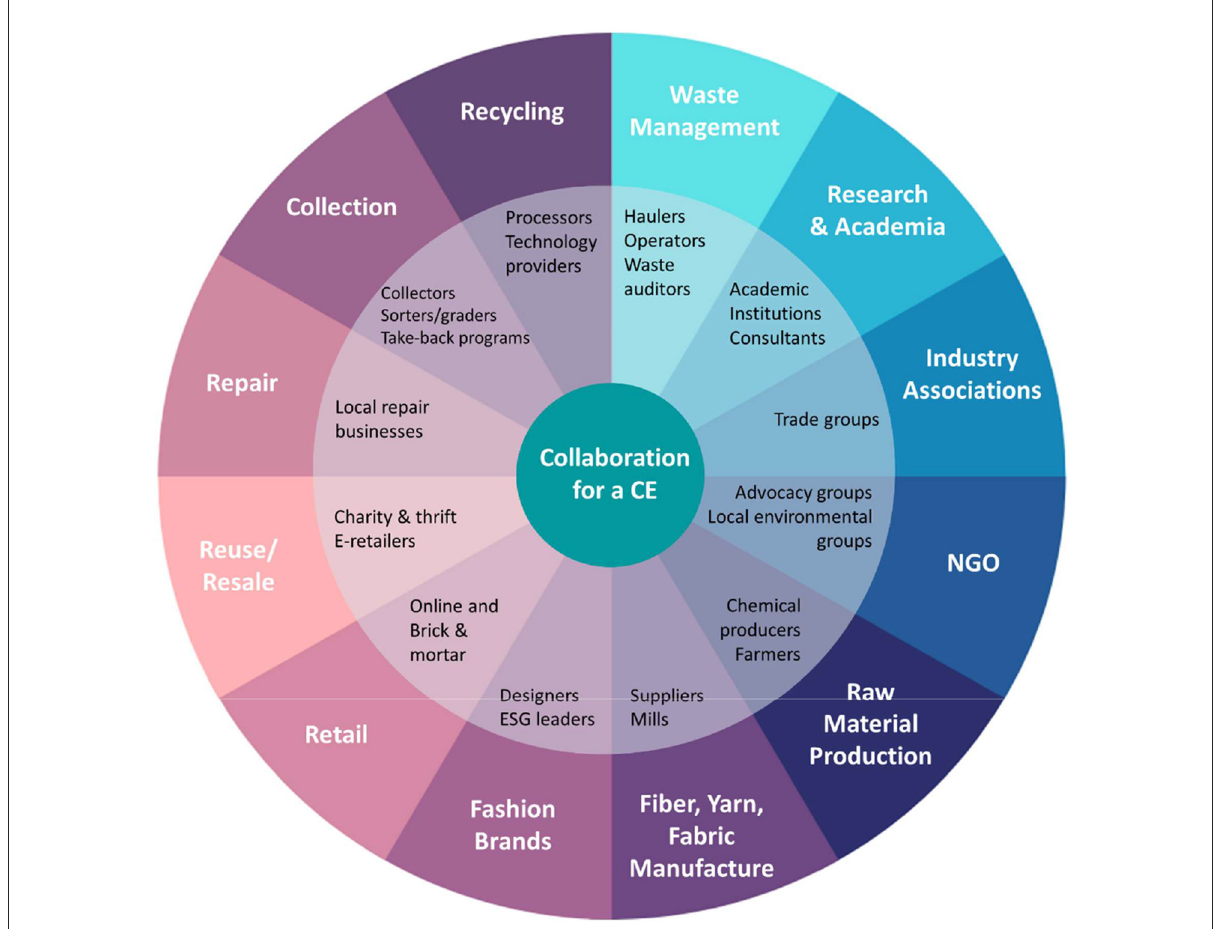
FIGURE5 Connections and collaborations needed between stakeholders to facilitate a CE for